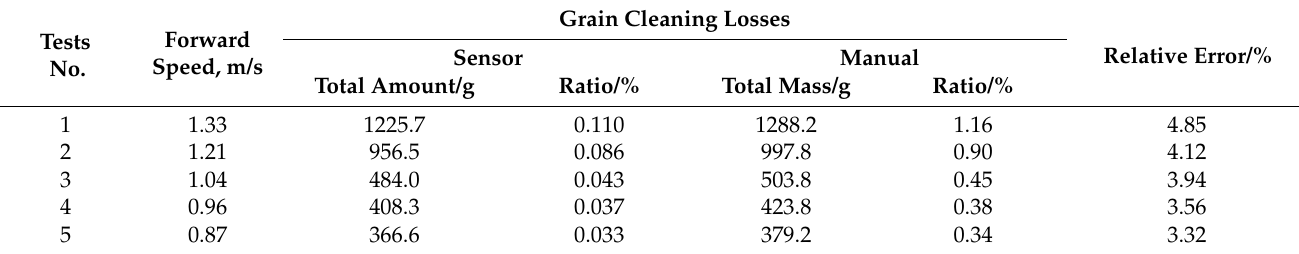
Table 2. Error analysis of sieve losses obtained by the sensor compared to manual